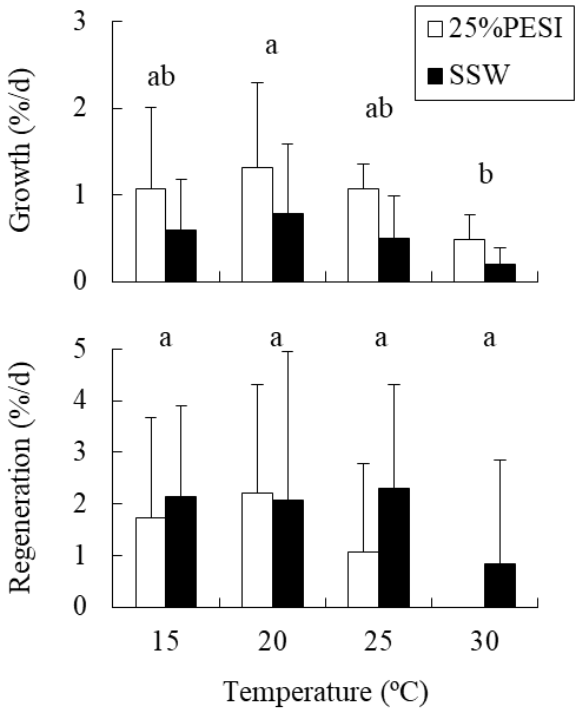
Figure 2. Relative growth and regeneration rates of Sargassum fusiforme holdfasts cultured in eight different treatments (Mean + SD, n = 6). Different small letters indicate statistical significance among different temperature treatments ( p < 0.05).